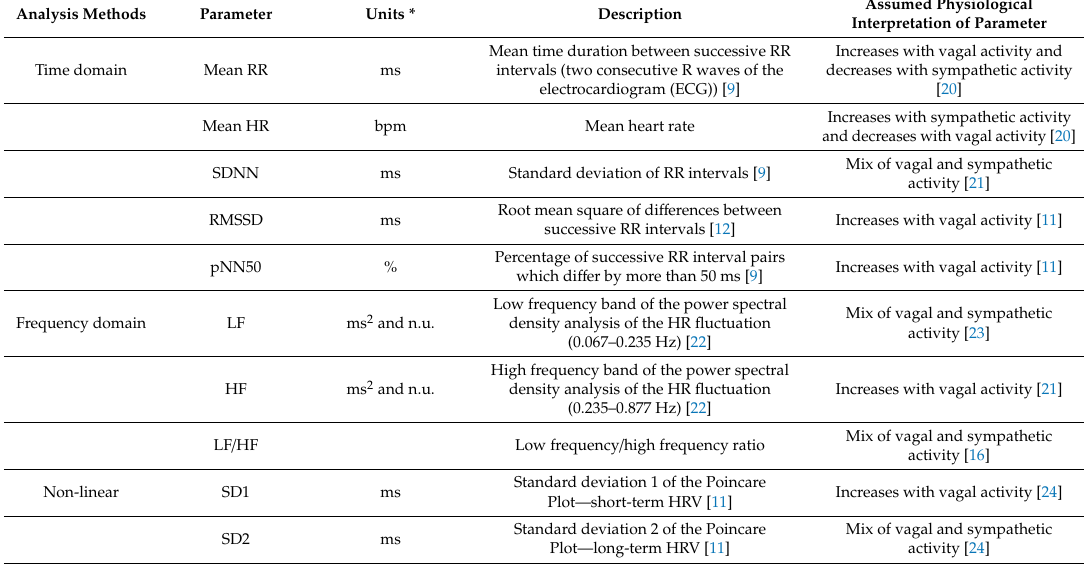
Table 1. Heart rate variability (HRV) parameters and their physiological